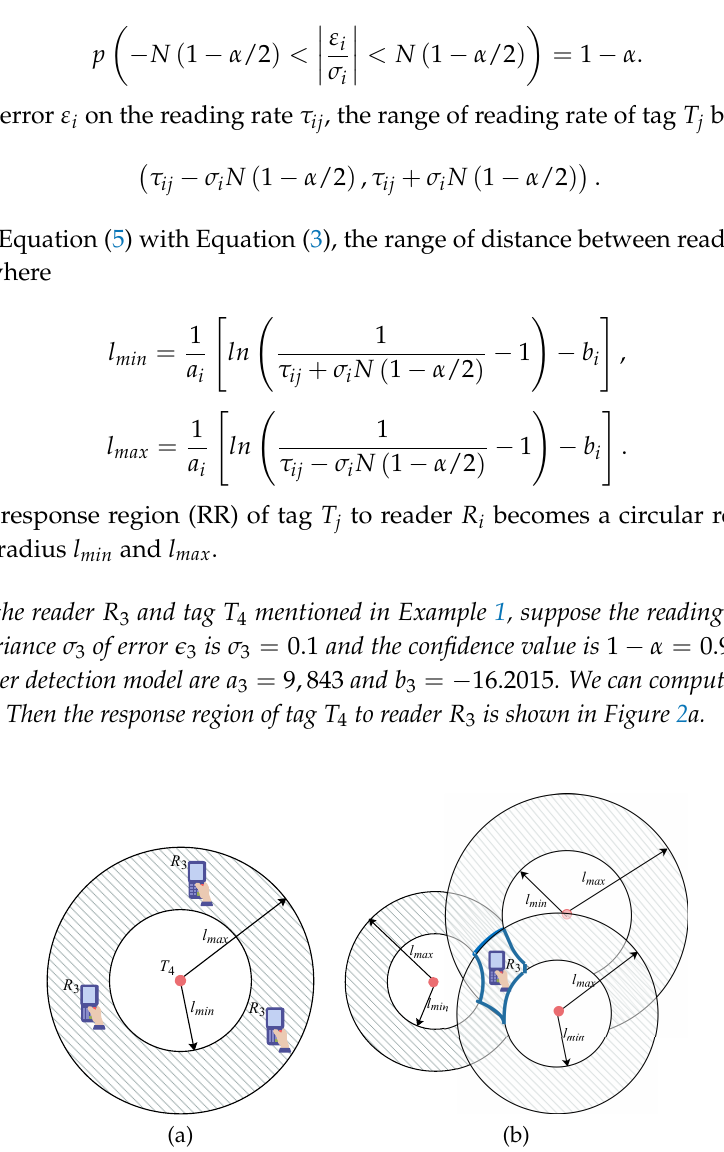
Figure 2. ( a ) The response region of tag T 4 to reader R 3 and ( b ) the Potential Location Region (PLR) of reader R 3